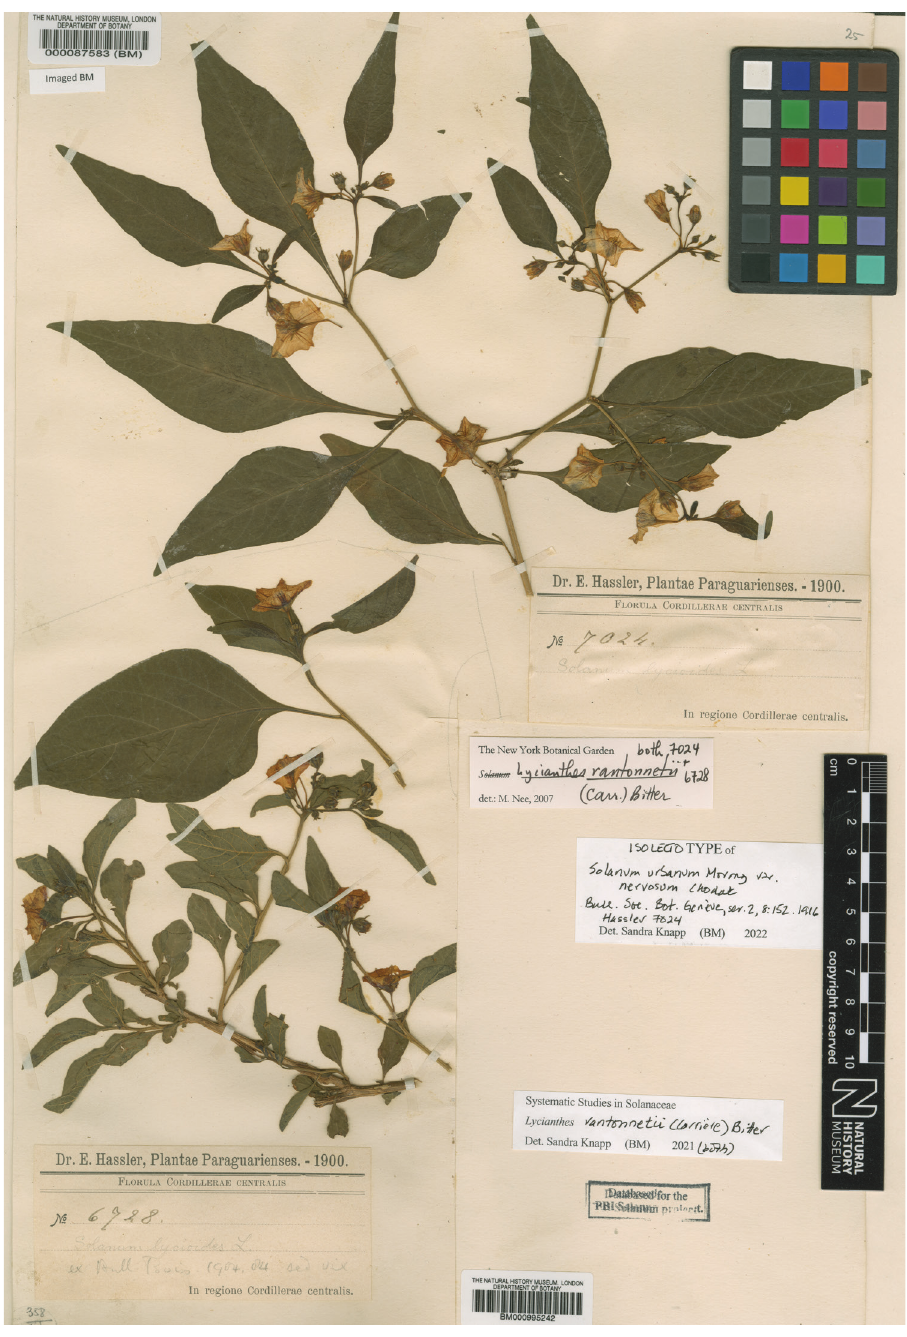
Figure 44. Lycianthes rantonnetii herbarium specimen. Paraguay. Cordillera: Hassler 7024 (isolectotype of S. urbanum var. nervosum Chodat, BM000087583) and Hassler 6728 (BM000995242). Courtesy of the Trustees of the Natural History Museum, London, reproduced with